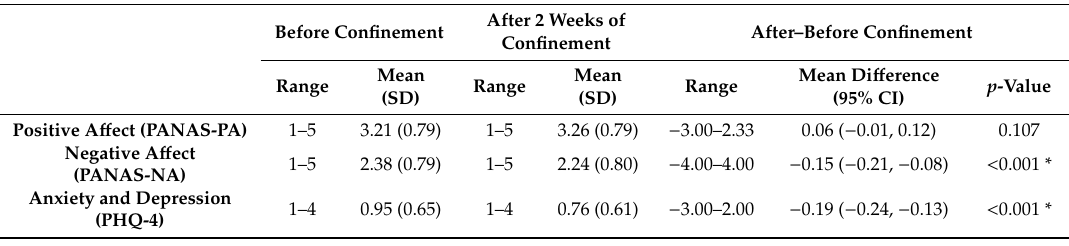
Table 1. Changes in positive a ff ect (PA) and negative a ff ect (NA) in the Positive and Negative A ff ect Schedule (PANAS), and anxiety and depression in the 4-item Patient Health Questionnaire (PHQ-4) before and after confinement ( n =